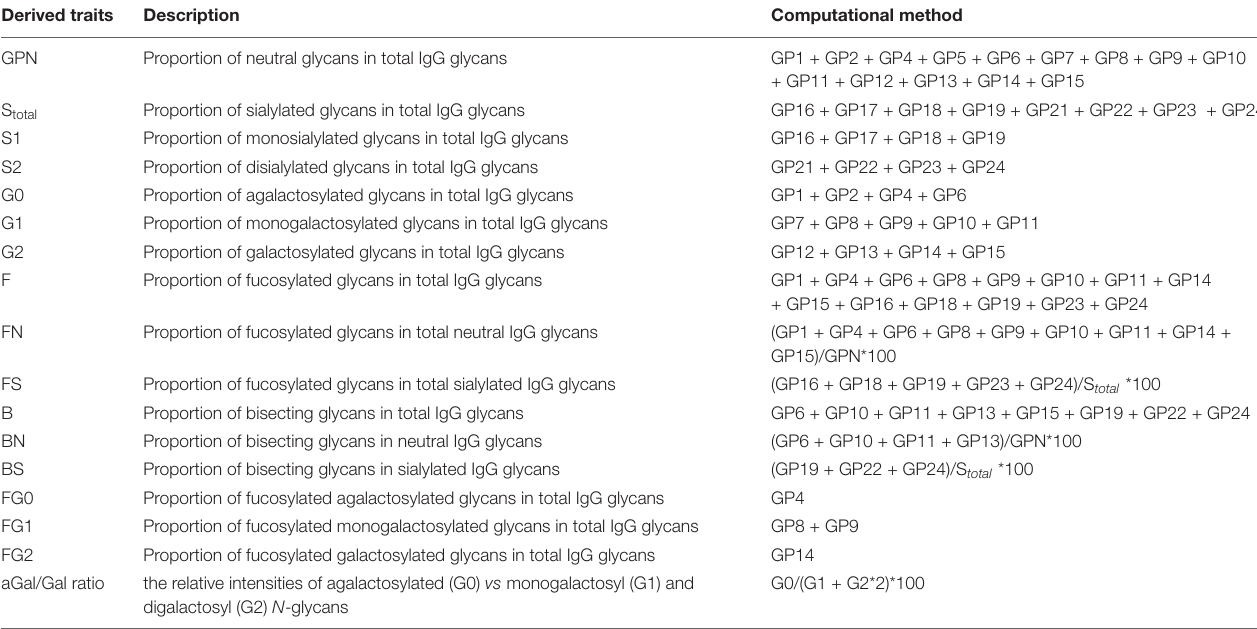
TABLE 1 | The calculation formula of derived